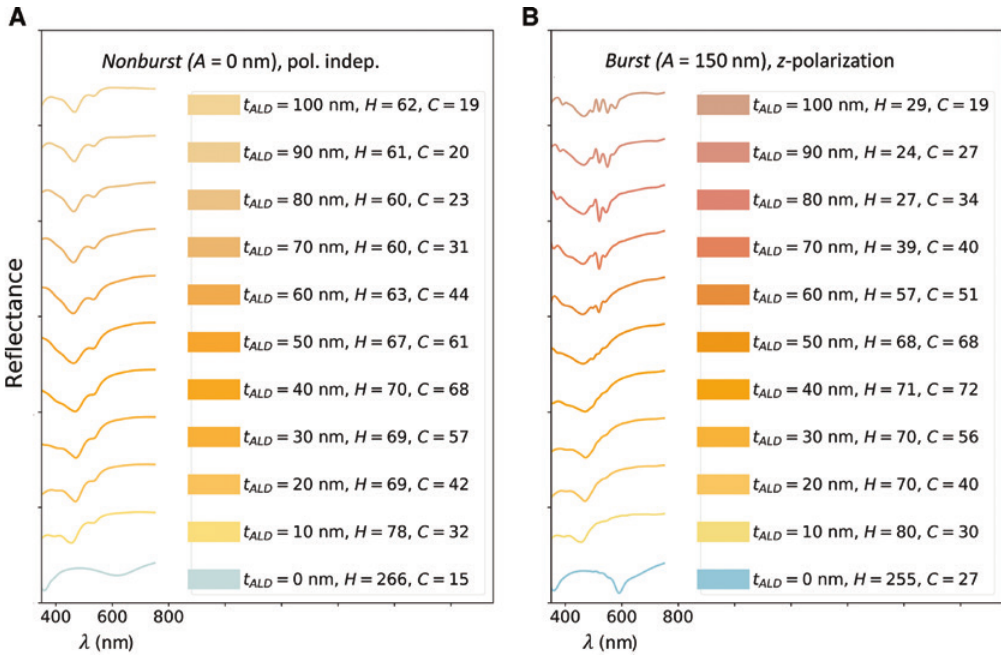
(nonburst vs. burst). ALD = 0.3 R and D = 75 nm for (A) nonburst (flat surface) and (B) burst ( L emb m